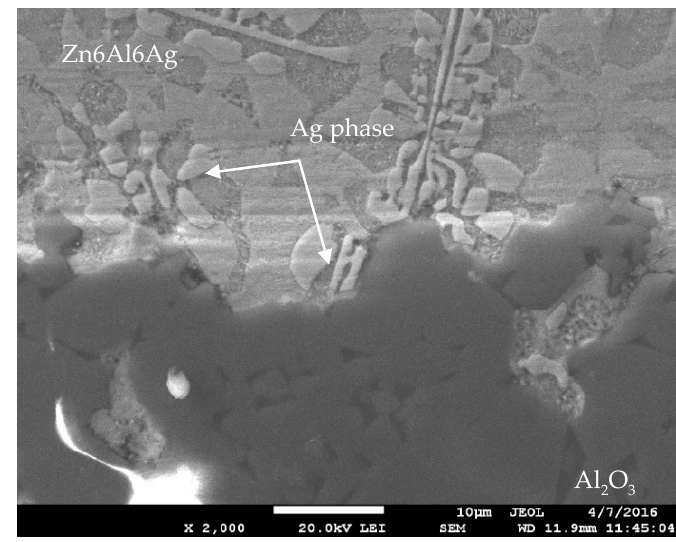
Figure 12. Microstructure of transition zone in Al 2 O 3 /Zn6Al6Ag joint.